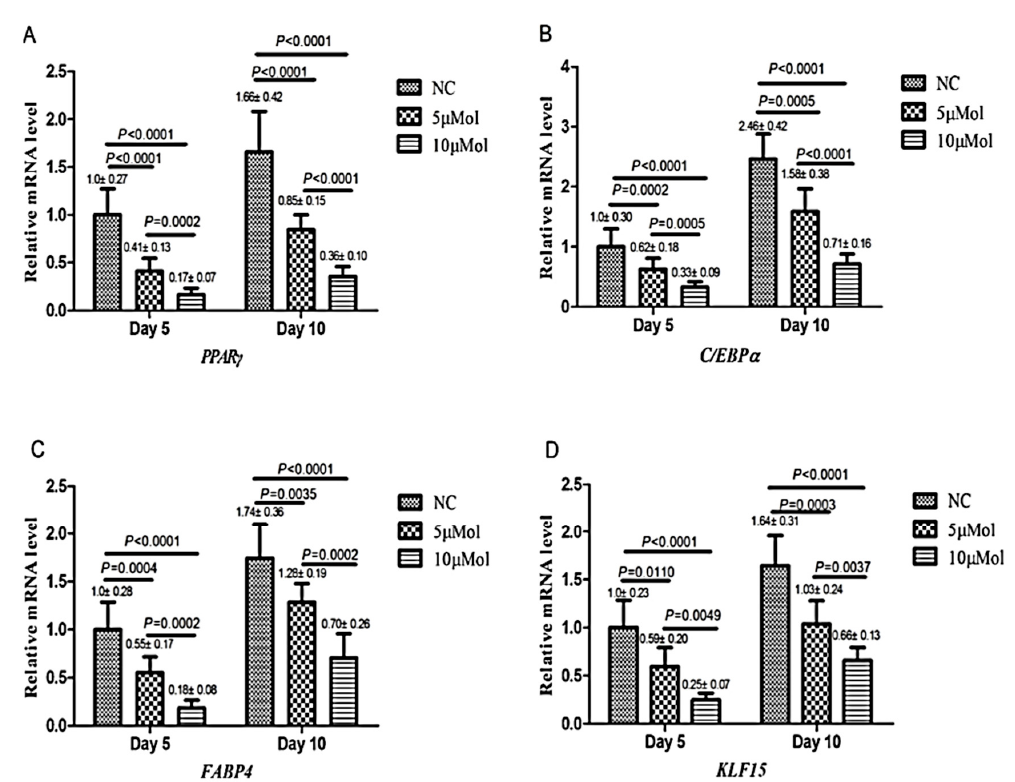
Figure 1. Curcumin’s inhibitory e ff ect on the mRNA expression of adipocyte markers and KLF15. qRT-PCR analysis of the mRNA expression of PPAR γ ( A ), C / EBP α ( B ), FABP4 ( C ) and KLF15 ( D ). All of the values are expressed as the mean ± S.D. ( n = 3). All the experiments were independently repeated at least three times. Adopted with the permission from Wang et al. with license number of4595960186796 [27].